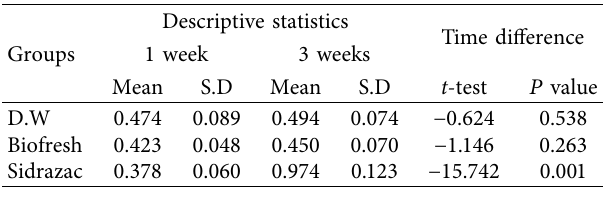
Table 3: Color diference between time intervals of immersion in the three mouthwashes.